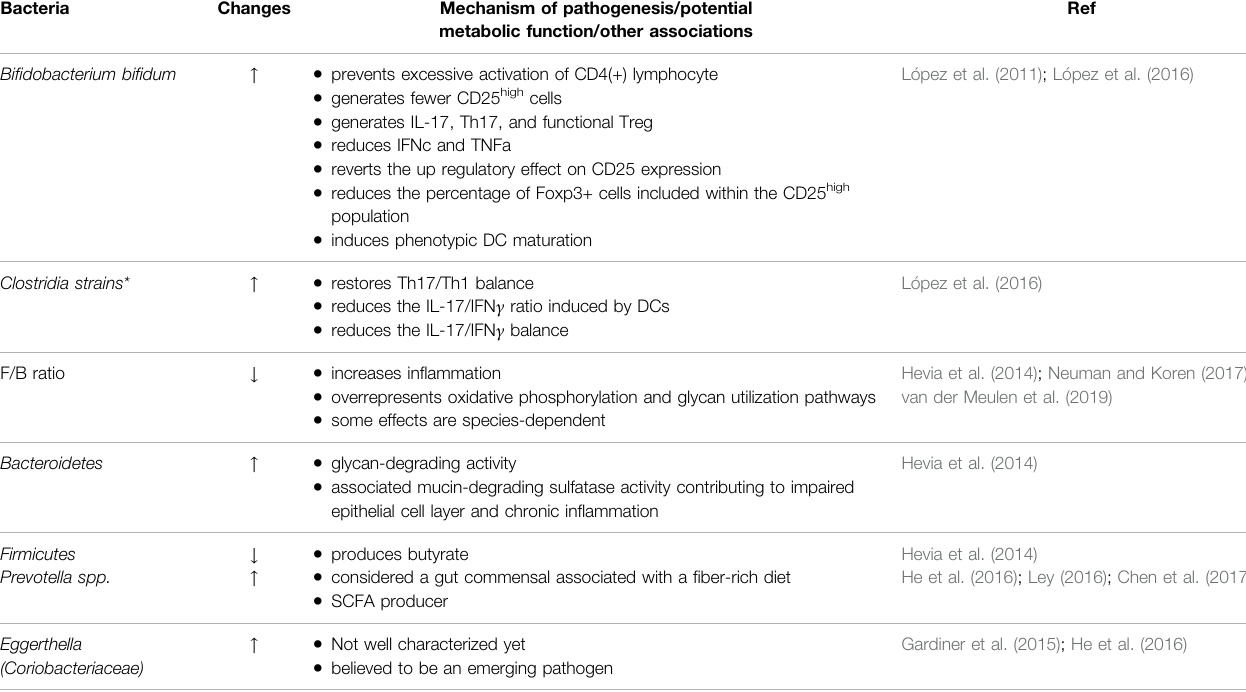
TABLE 1 | The shift of microbiota in SLE. Bacteria